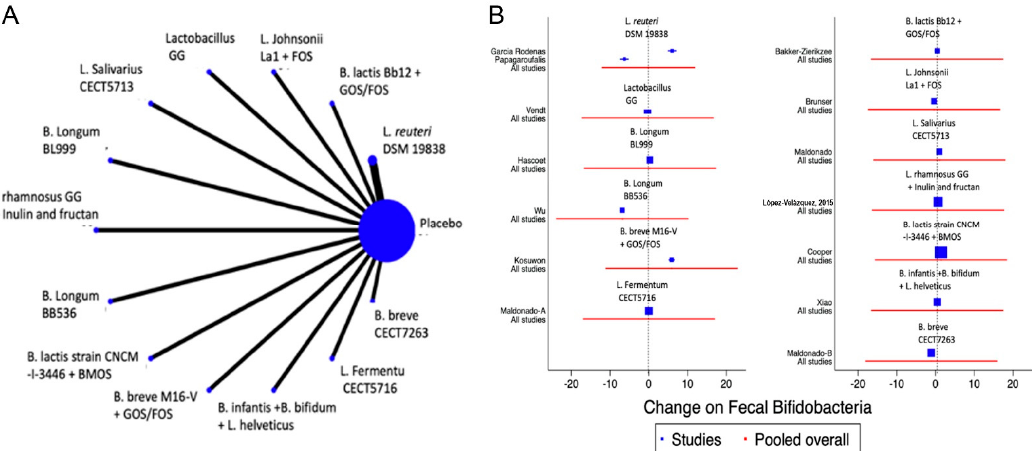
Figure 6. Network meta-analysis for probiotics and change on faecal Bifidobacteria . ( A ) Network